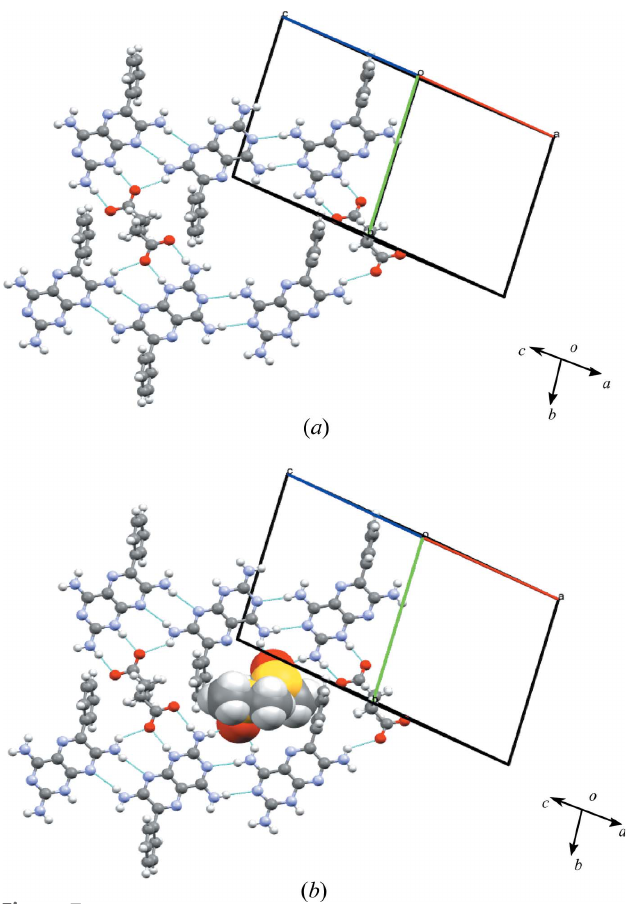
Figure 7 ( a ) The eight-membered hydrogen-bonded cyclic host network with a cavity of 15.3 (cid:8) 10.0 A˚ dimensions and ( b ) the cavity filled with two DMSO molecules as guests in 1c (cid:3) DMSO.